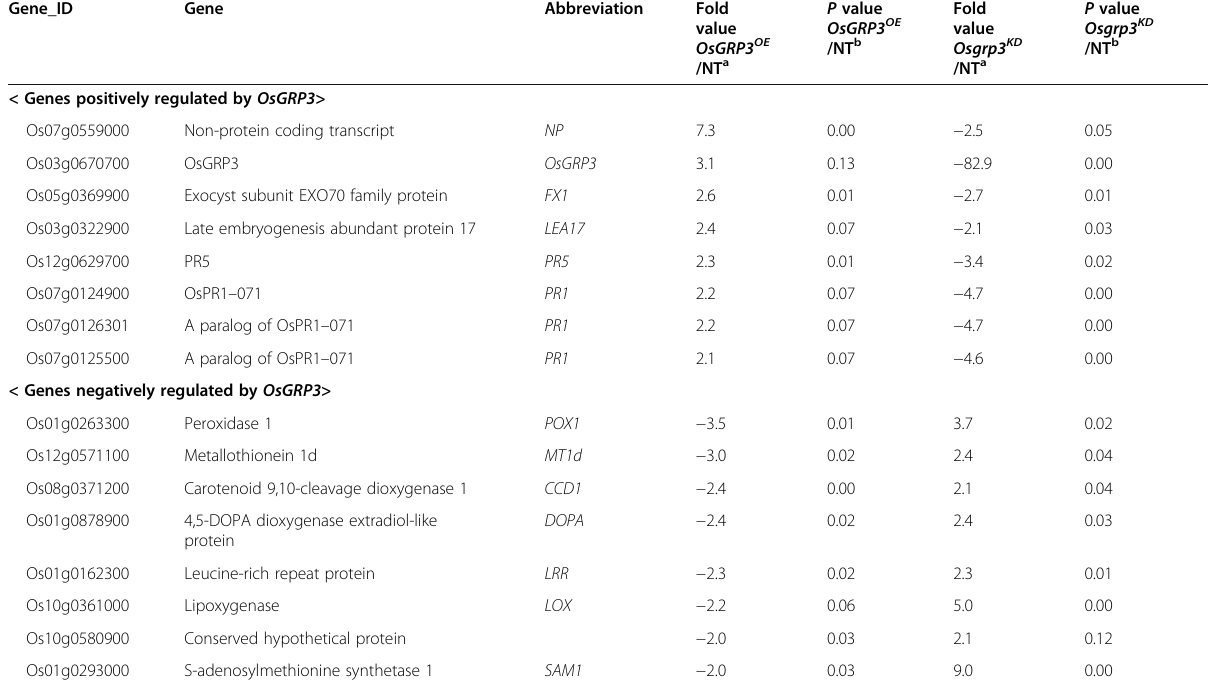
Table 1 List of candidate genes regulated by OsGRP3 Gene_ID Gene